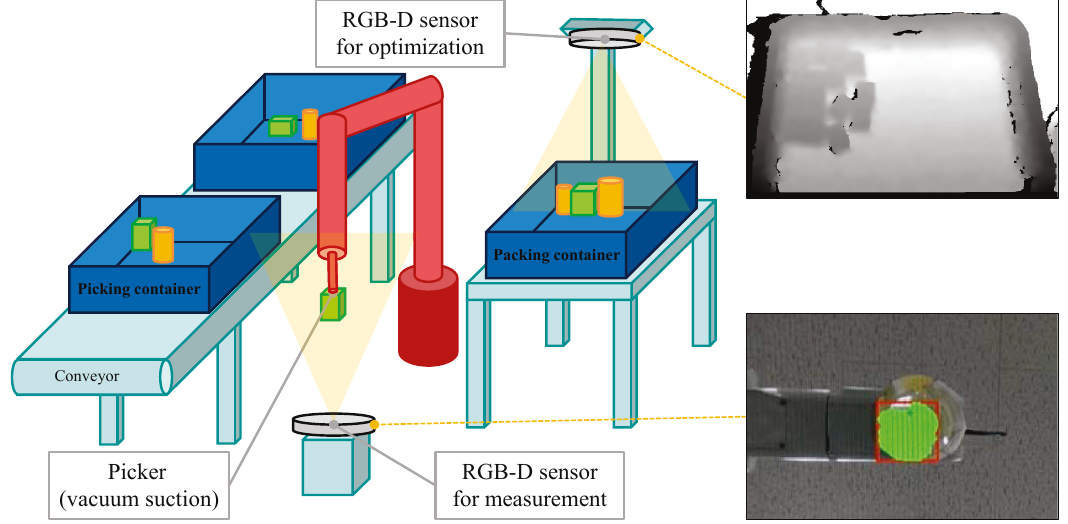
Figure 1. The illustration of the proposed system and the examples of the data from the